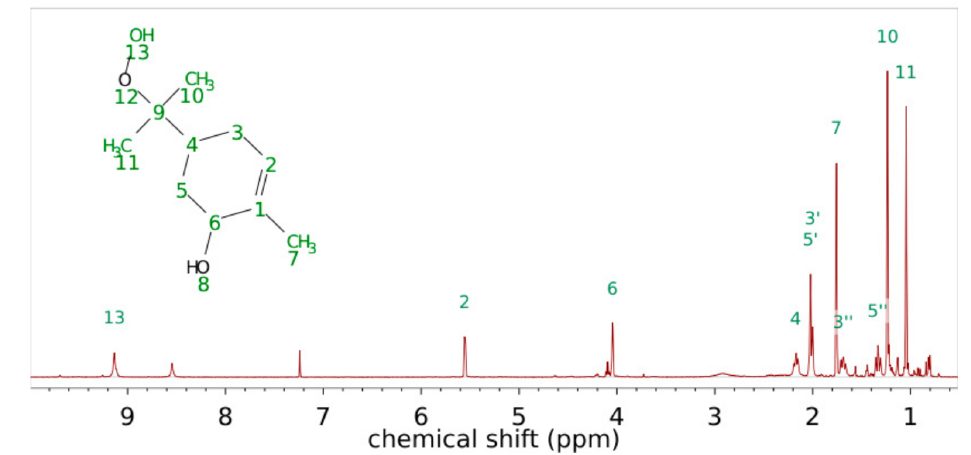
Figure 7. 1 H-NMR spectrum of α -pinene hydroxy hydroperoxide at 600